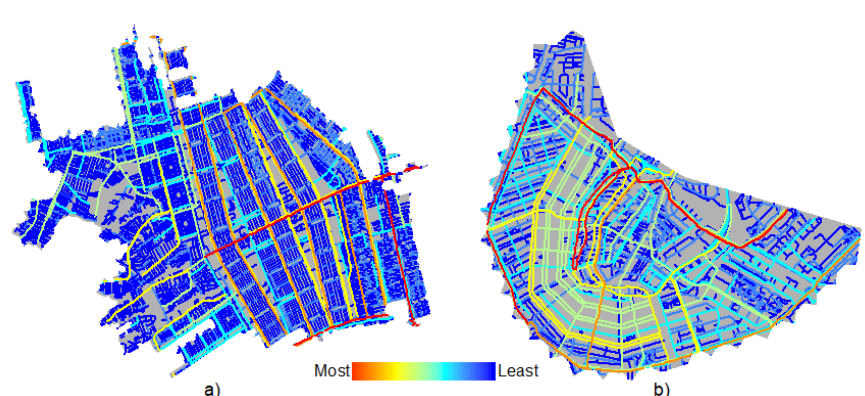
Figure 3. Natural Streets compared in neighborhoods. Warmer colors (red) indicate high connectivity, while colder colors indicate a lower connectivity (blue) Panel ( a ) shows the northwestern worker district of Brasilia and panel ( b ) shows the residential area around the city center of Amsterdam. It is shown that the roads in Brasilia are not very connected as a whole; there are 4 disjointed geometric arms in the middle running from north to south crossed by the red (highest connectivity) street which have no support from each other, while Amsterdam shows interconnectivity within the city center, with an onion-like support.